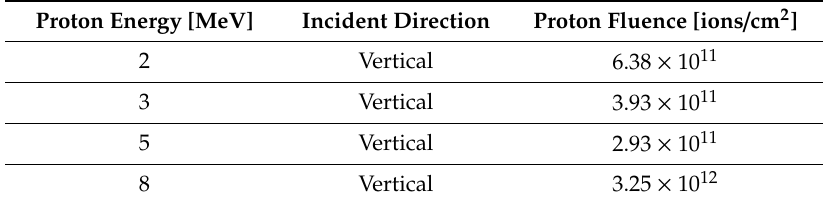
Table 1. Experimental